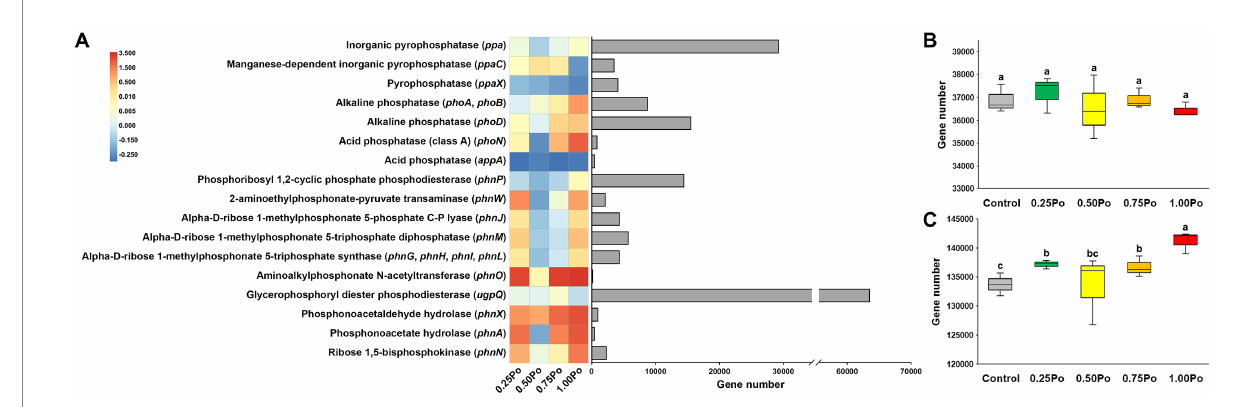
FIGURE 2 Fold change in abundance of the genes involved in P transformation compared with control (heatmap) and the total abundance of each gene (bar plot; A ). Total abundance of genes involved in Pi dissolution (B) and Po mineralization (C) . Boxes with different letters (shown above each) are significantly different ( p < 0.05) as revealed by the Kruskal–Wallis rank-sum test.